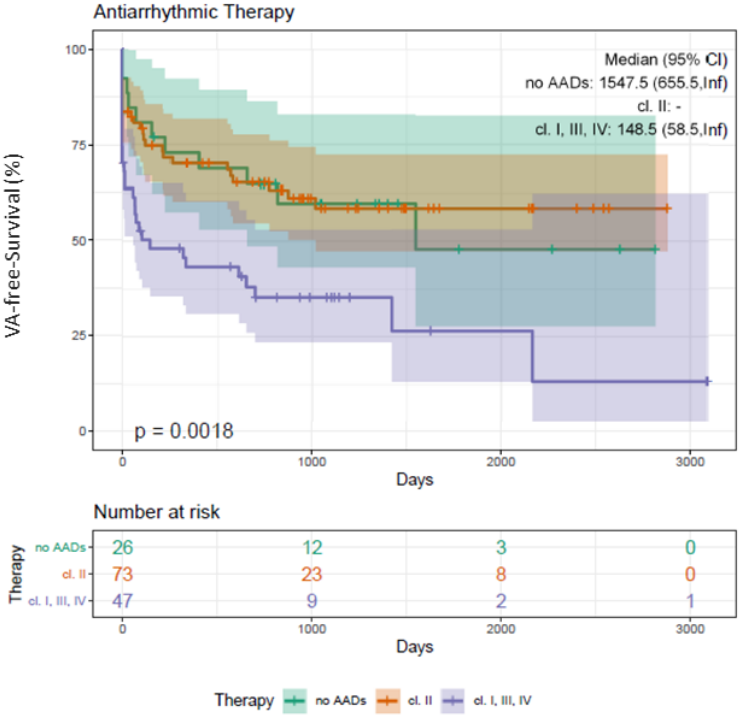
Figure 4. Kaplan–Meier plot on freedom from VA recurrence in patients undergoing RMN ablation